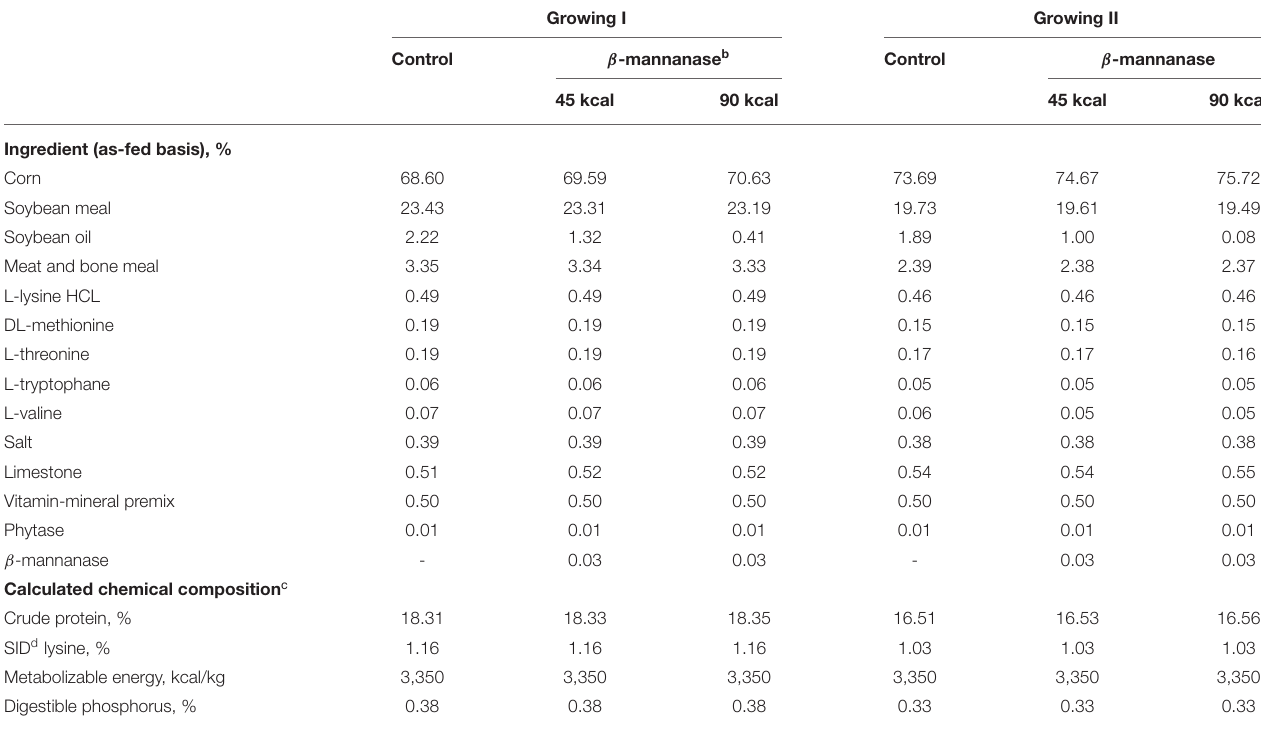
TABLE 2 | Composition of growing pig feeds a